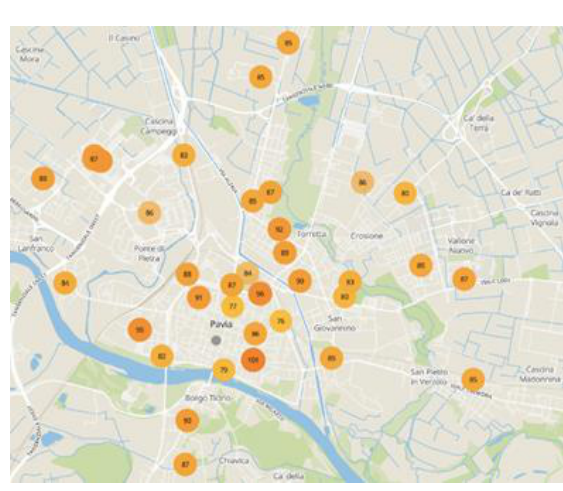
Figure 3. Maps of the sensors deployed in